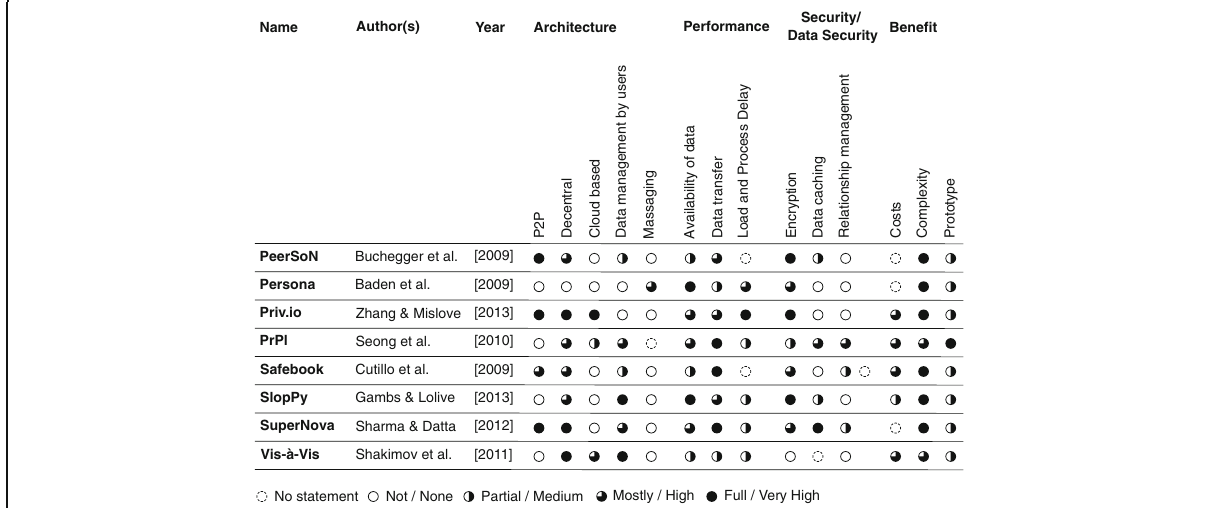
Fig. 1 Results of the degree of the fulfillment of the system comparison